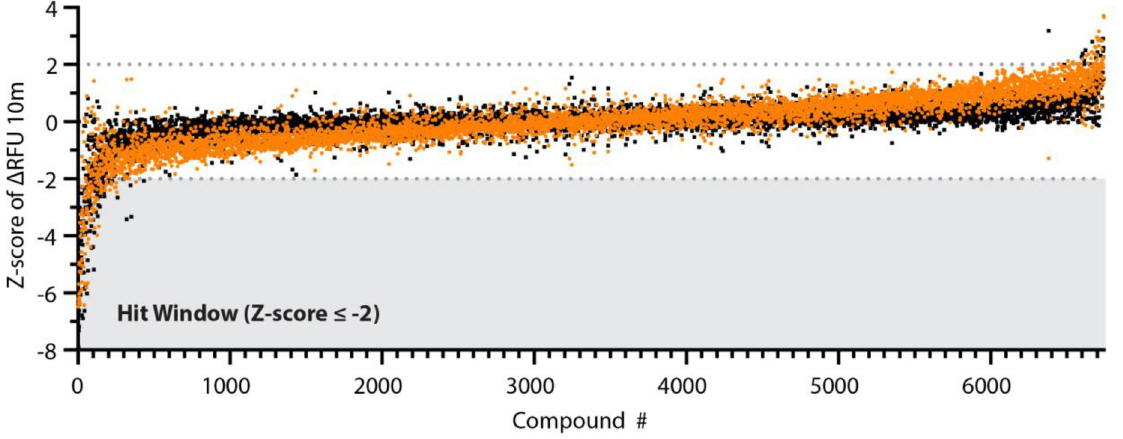
Fig 2. Broad library screen. Screen of the Broad Repurposing Library. Library was screened at a concentration of 50 μ M against both Ac- VKLQ-AFC (black) and Ac-Abu-Tle-Leu-Gln-AFC (orange). Hit window was considered for compounds falling below Z-score � -2 against both substrates and consisted of 50 compounds. Compounds ordered by average